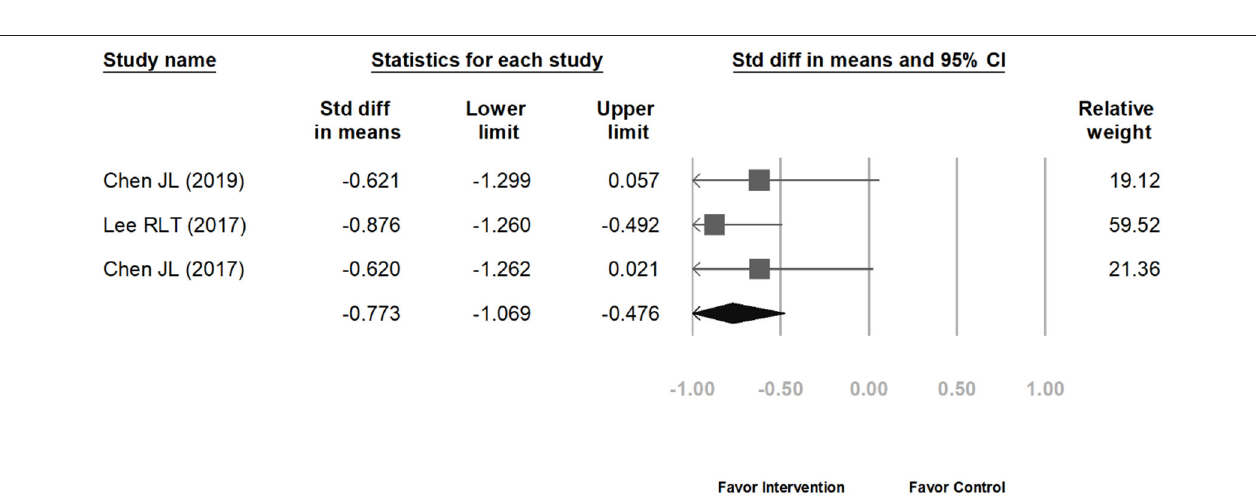
FIGURE 2 | Forest plot showing the effect of mobile health technology on weight control in adolescents and preteens as compared with control groups, overall effect.